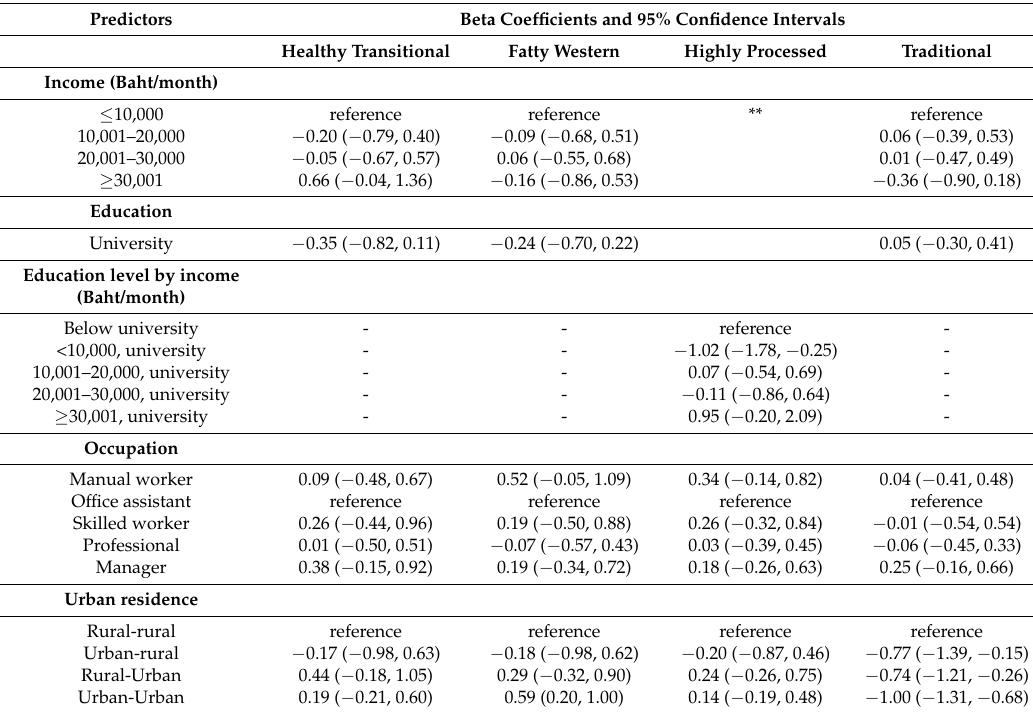
Table 2. Multivariable linear regression of socio-demographic predictors in 2013 and dietary intake pattern scores in 2015 in 486 Thai men.